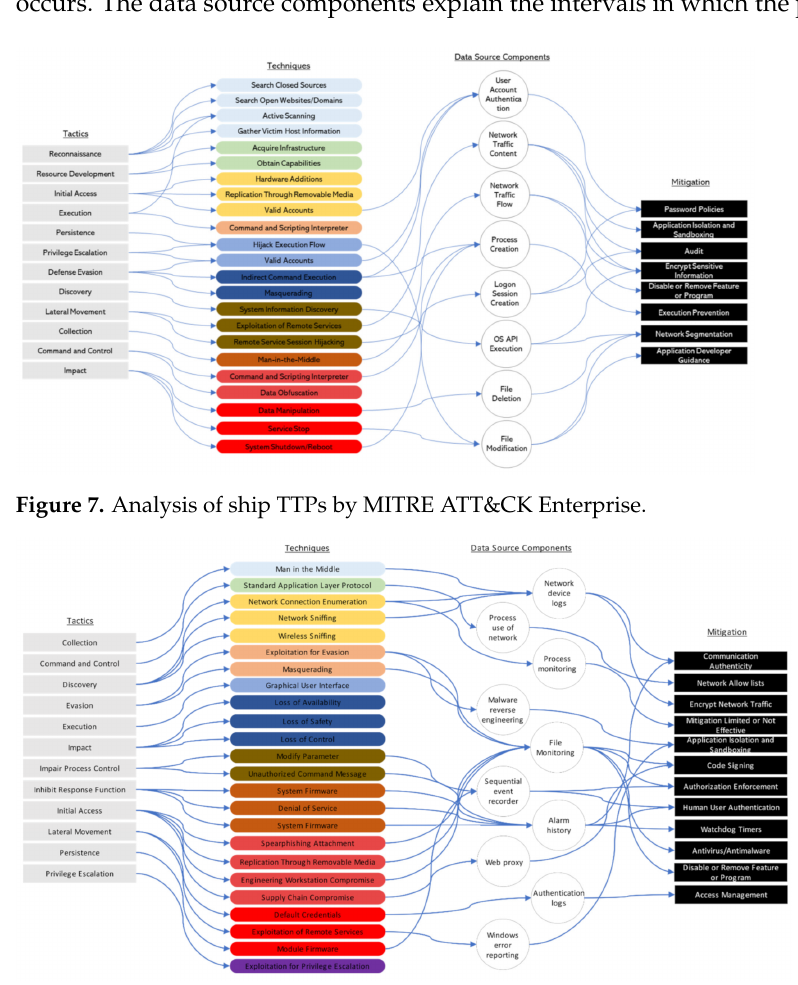
Figure 8. Analysis of ship TTPs by MITRE ATT&CK